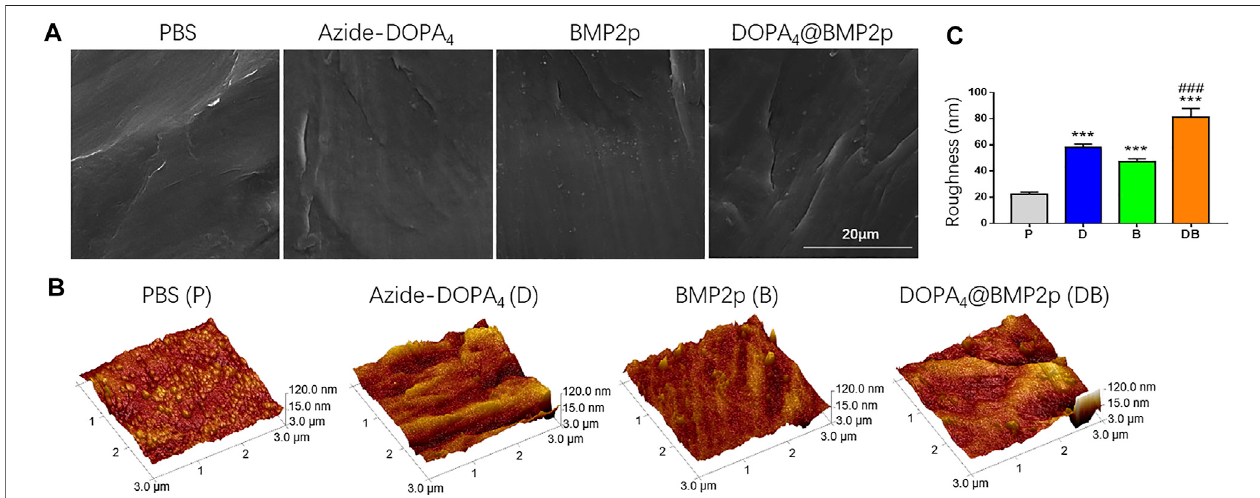
FIGURE 1 | Surface morphology of PEEK after different modi fi cations. (A) SEM images of the PEEK substrates with different treatment methods, (B,C) AFM images and the surface roughness measure of the PEEK substrates after different treatment methods. Statistically signi fi cant differences are indicated by *** p < 0.001 compared with the PBS-PEEK group and ### p < 0.001 compared with the BMP2p group. Abbreviations: P (PBS), D (Azide-DOPA 4 ), B (BMP2p), and DB (DOPA 4 @